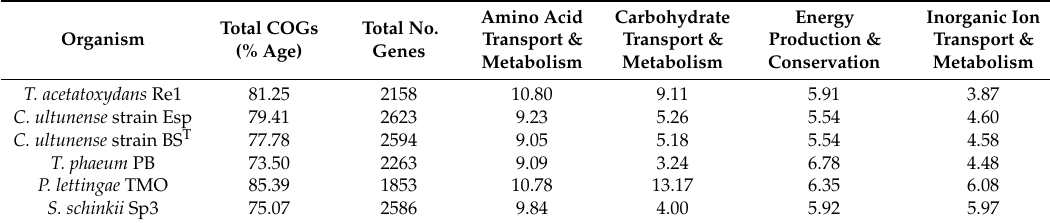
Table 2. Comparison of COG (Clusters of Orthologous Groups) analysis for the SAOB C.